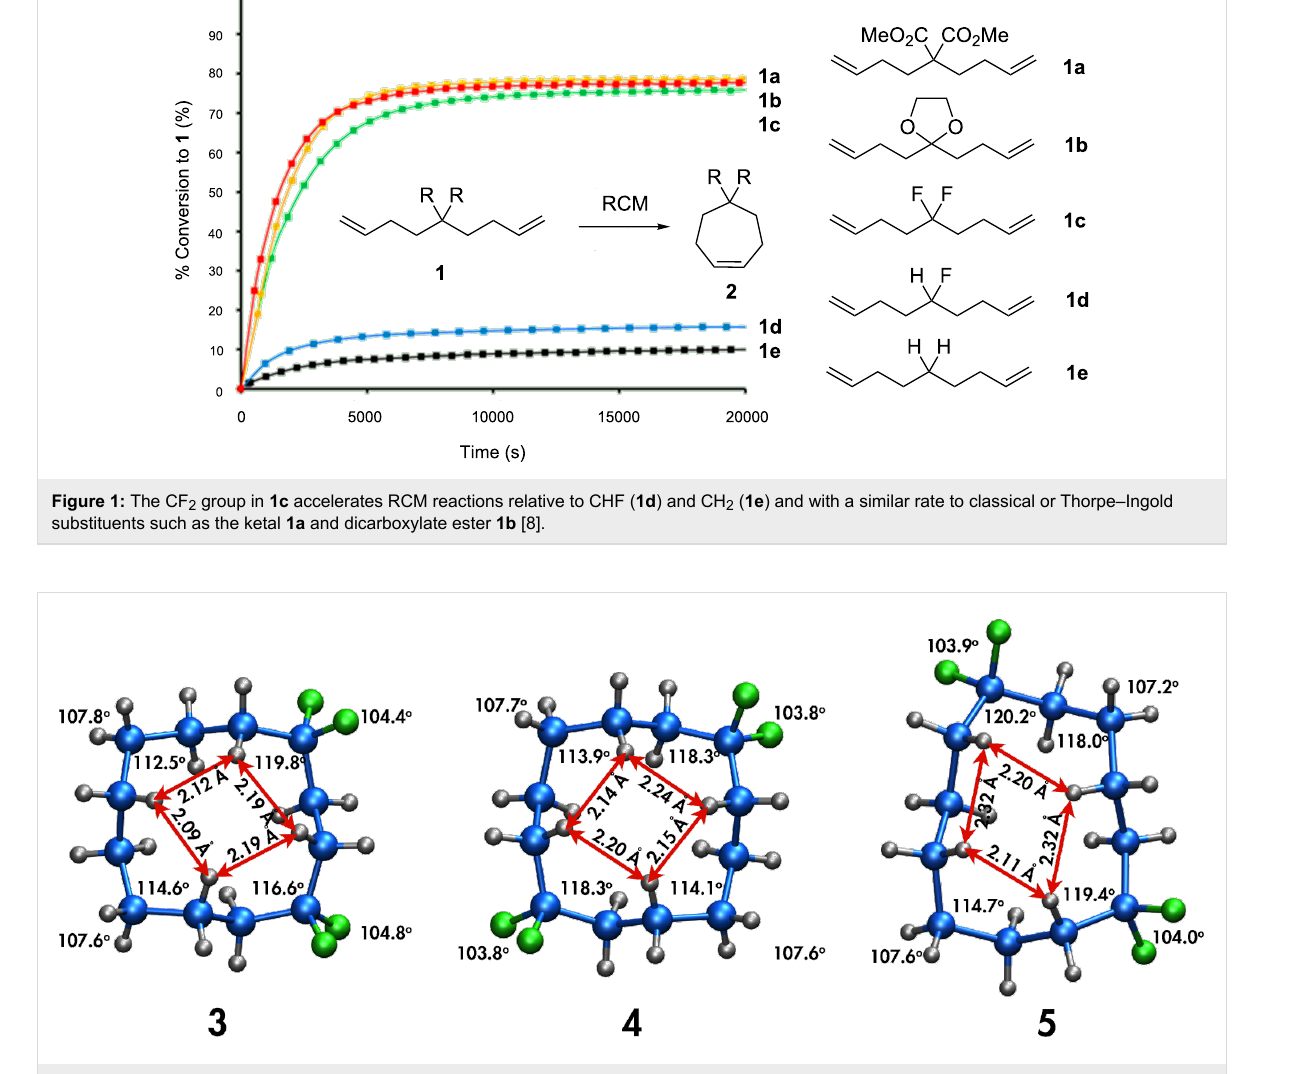
Figure 2: X-ray structures of a) 1,1,4,4- ( 3 ) b) 1,1,7,7- ( 4 ) and c) 1,1,6,6- ( 5 ) tetrafluorocyclododecanes. The CF 2 groups locate at the corners, even for 5 which gives rise to a distorted ring conformation